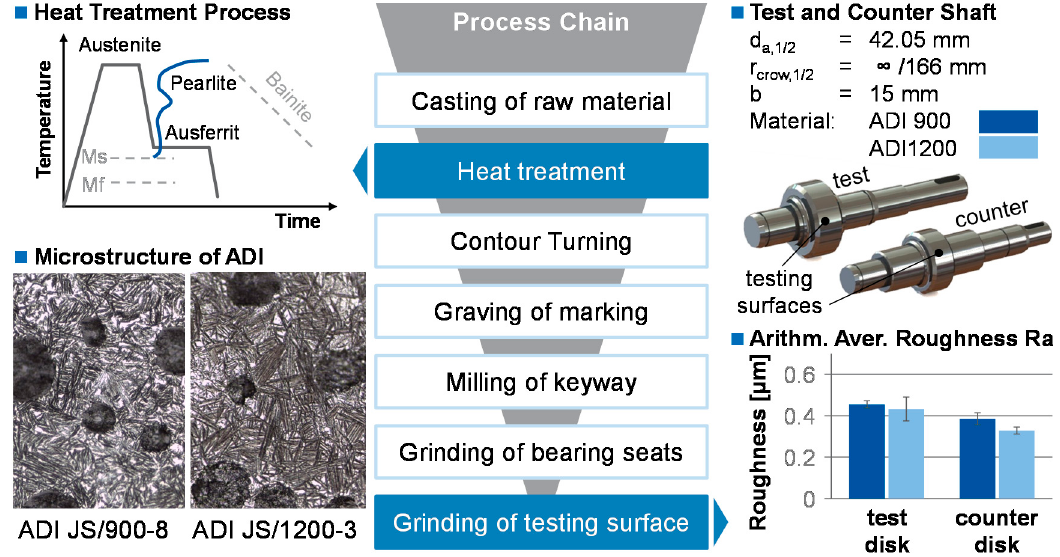
Figure 3. Manufacturing chain and production quality of ADI test parts.